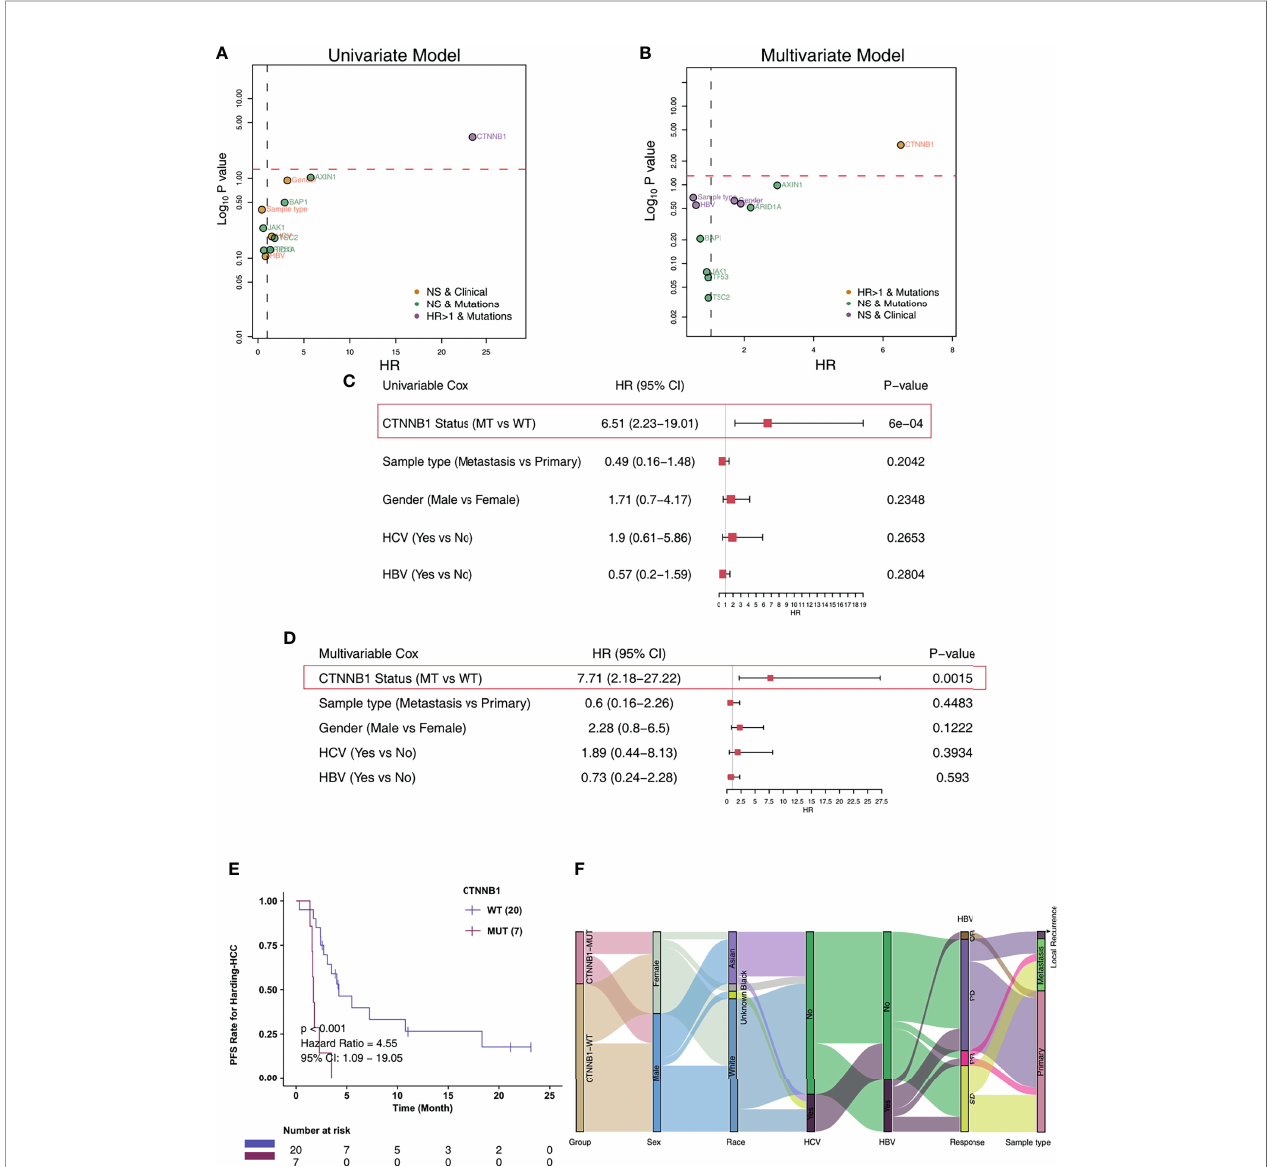
FIGURE 2 | CTNNB1-MUT was associated with shorter PFS in HCC patients responding to ICI treatment. Univariable Cox regression analysis (A) and multivariable Cox regression analysis (B) in subgroups of mutation, sample type, HBV status, HCV status, and gender in the Harding-HCC cohort. Univariable Cox regression analysis (C) and multivariable Cox regression analysis (D) in subgroups of CTNNB1 mutation status, sample type, HBV status, HCV status, and gender in the Harding-HCC cohort. (E) Kaplan-Meier curves comparing the progression-free survival (PFS) of patients with CTNNB1-Mutant (CTNNB1-MUT) and patients with CTNNB1-wildtype (CTNNB1-WT) in the Harding-HCC cohort. (F) A Sankey diagram visualizing the clinical characteristics of CTNNB1-MUT and CTNNB1-WT patients in the Harding-HCC